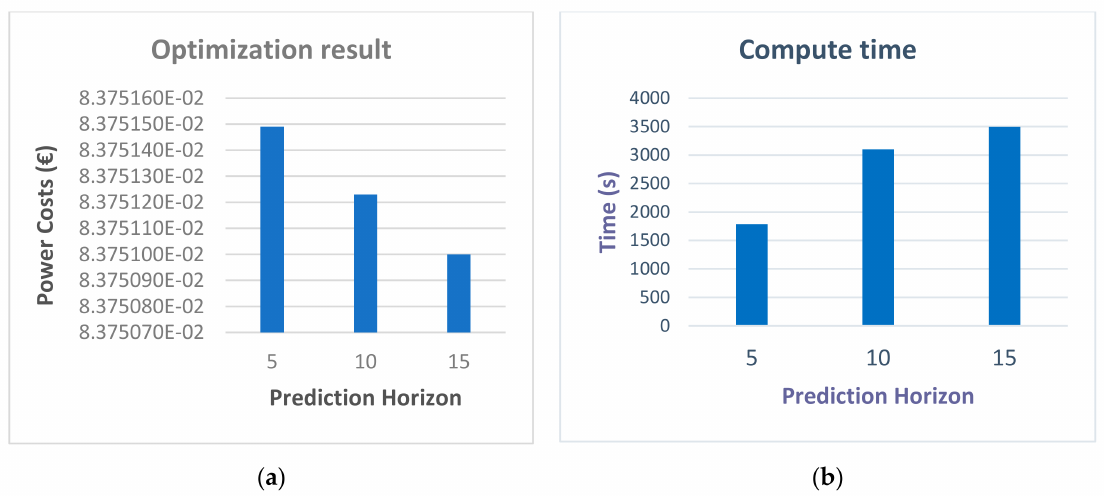
Figure 8. Performance analysis of the EMS for different prediction horizons. ( a ) Optimization result, ( b ) Compute time.